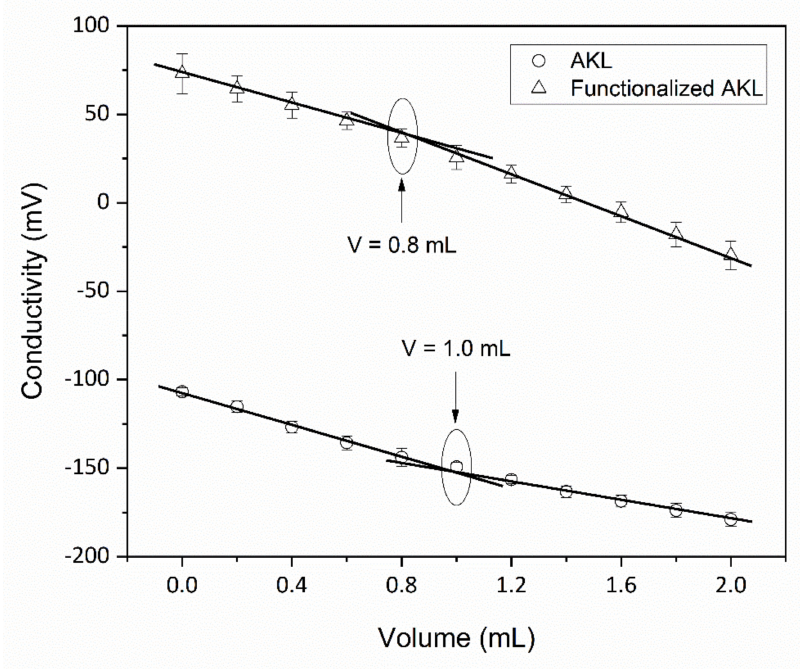
Figure 1. Measurement of conductivity of the AKL and functionalized